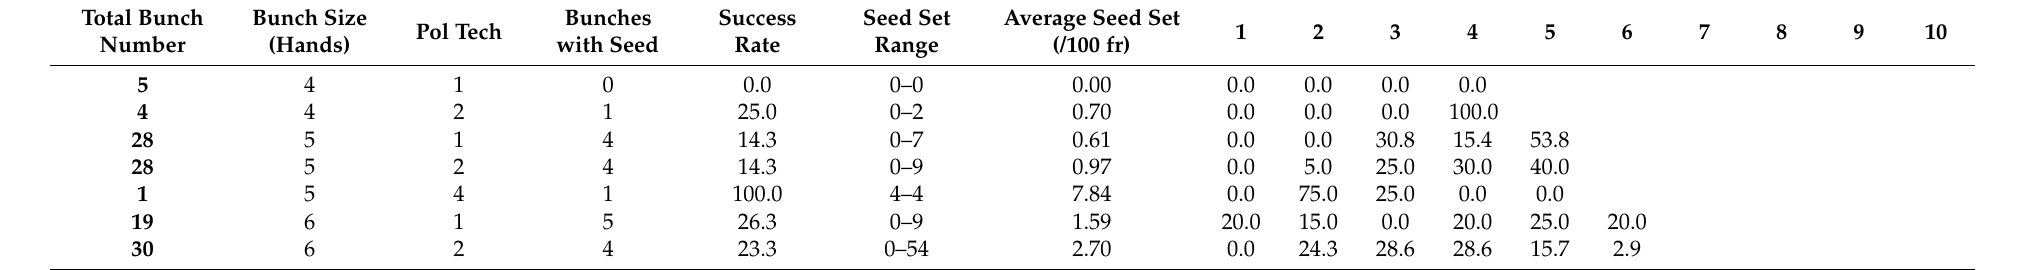
Table A3. Percentage seed set per hand and by number of hands per bunch in “Nshonowa” pollinated with “Calcutta 4”, using different pollination techniques, between January 2016 and January